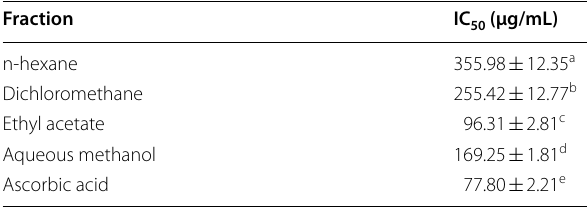
Table 8 IC values for DPPH scavenging activity of fractions 50 from leaf extract of I.